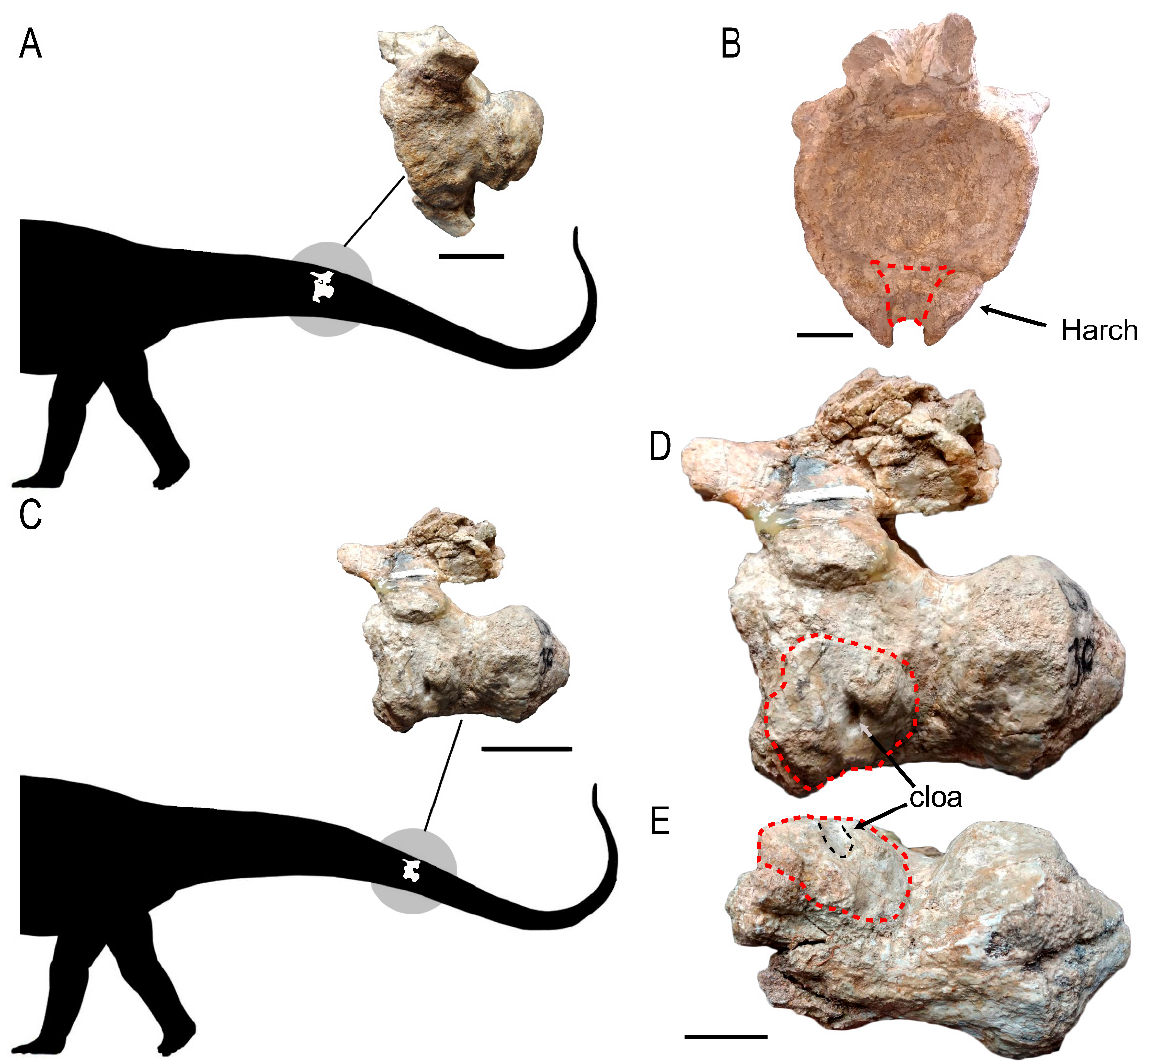
Figure 2. Caudal vertebrae showing the delimitation of the pathological area: ( A ) localization of MAU-Pv-LI-601 within a graphical scheme of the tail of an indeterminate sauropod; and ( B ) an anterior view of the vertebral centrum; ( C ) MAU-Pv-LJ-472/1 located within the graphical scheme of the tail; ( D ) MAU-Pv-LJ-472/1 in lateral view and ( E ) in ventral view. The extent of pathological tissue on the vertebral surface is marked by a red dashed line; the cloaca is marked by a black arrow in lateral view ( D ) and by a black dashed line in ventral view ( E ). The haemal arch is marked by a black arrow in the anterior view ( B ). Abbreviations: Cloa, cloaca; Harch, haemal arch. Scale bars equal 5 cm in ( A , C ) and 3 cm in ( B , D , E ).